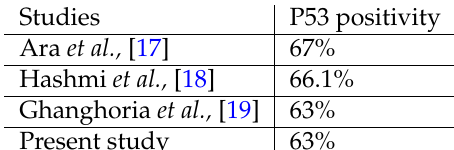
Table 7. P53 positivity with other studies Studies